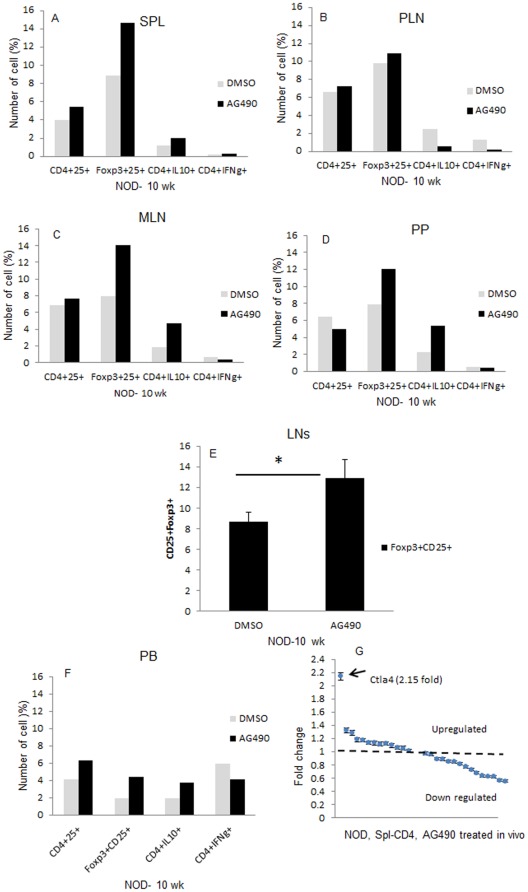
AG490 upregulates expression of Foxp3 regulatory CD25+ T-cells in vivo.A- Prediabetic NOD mice (4 week) were treated either with AG490 or DMSO three times per week for 5 consecutive weeks and they were sacrificed one week after the last injection at week 10. Data represents pool cell suspensions of 5 NOD mice per group and is gated on live CD4+ T-cells. AG490 treatment significantly increases number of Foxp3 regulatory T-cells (p<0.004) (A–D). E- CD25+Foxp3+ gated population on CD4+ T-cell of several lymph nodes in AG490 and the sham treated control NOD mice. Bars represent standard deviation of the mean. F- Whole blood of NOD mouse (pool of 5 mice/group) treated as described above was stained directly with antibodies indicated as described in materials and methods. Data of gated CD4+ T-cells are shown. G- Total RNA from purified CD4+ T-cells of splenocytes of NOD mice (10 weeks old) treated either with AG490 or DMSO from 5 weeks were subjected to real-time RT-PCR and expression of the immune response genes was screened as described in materials and methods. Data shown is the mean of fold change expression of 18 genes after they were normalized based on expression of two housekeeping genes and then compared with the expression of the same gene in DMSO treated control NOD mice. Spl = spleen, PLN = pancreatic lymph node, MLN = mesenteric lymph node, PP = Peyer's patches, PB = peripheral blood.